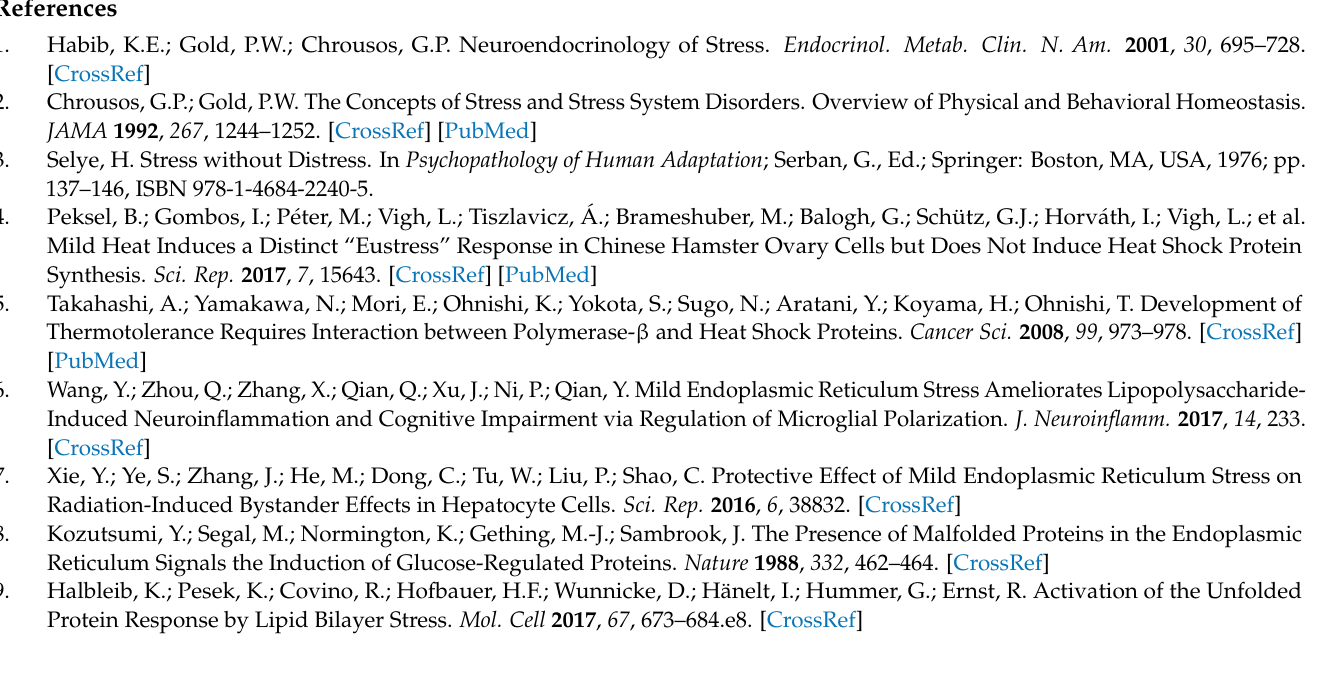
Figure S3. Cellular survival of non-primed cells treated with different doses of (a) benzyl alcohol (BA) or (b) tert -butyl hydroperoxide (TBHP), Figure S4. Experimental setup for acquired stress tolerance, Figure S5. The effect of heat priming on cellular ATP level of CHO cells, Figure S6. Heatmap representation of canonical pathways significantly affected in heat-treated CHO cells. Figure S7. mRNAs, Table S2a–c. List of the 50 most enriched pathways based on Ingenuity Pathway Analysis by the comparison of primed samples and control, Table S3. Lipidomic dataset for lipid